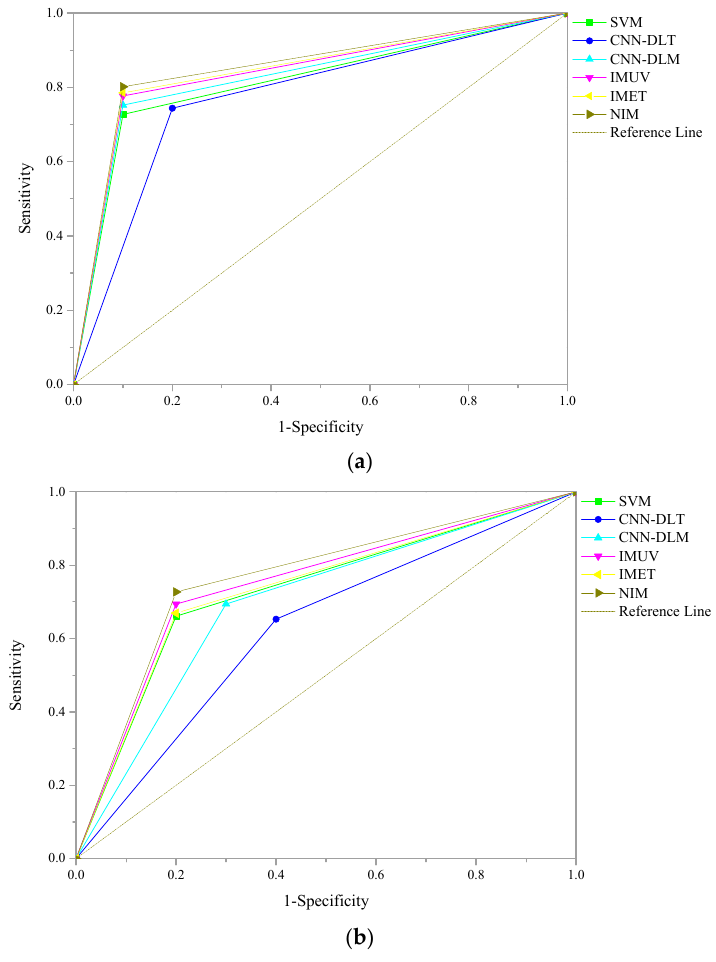
Figure 4. The receiver operating characteristics (ROC) curve of each model with the energy training data and the testing data. ( a ) Evaluation results with the testing data set of the year ( t − 2 ) ; ( b ) evaluation results with the testing data set of the year ( t − 3 ) . The confidence level is